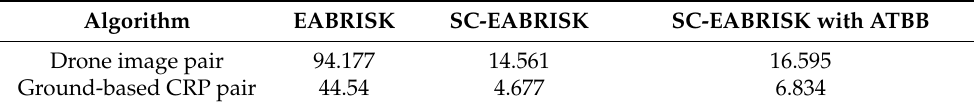
Table 4. Comparisons of the TC (seconds) by using CRPs with different image matching algorithms.